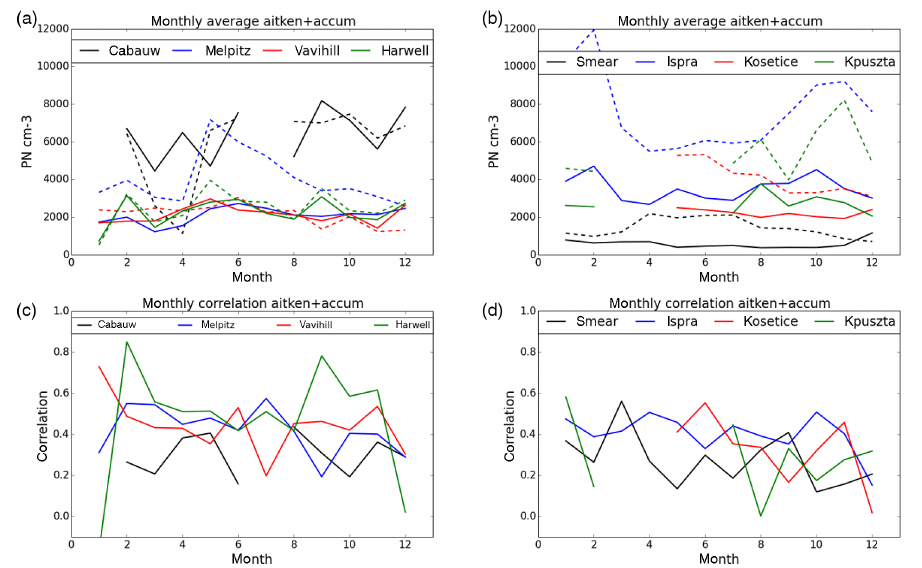
Figure 6. A comparison of the seasonal variation of the monthly averaged model predictions and observations of the particle number concentrations (particlescm − 3 , a – b ), and the correlation coefficients of the hourly predicted and measured concentration values within each month, at eight selected measurement sites in 2008 (c – d) . In the upper panels (a – b) , the solid lines are model predictions, and the dotted lines are measurements. The modelled values are the predictions of the LOTOS-EUROS model. The nucleation mode has been excluded; the values correspond to the size fractions 30–250nm and 10–1000nm for the observations and the model computations,